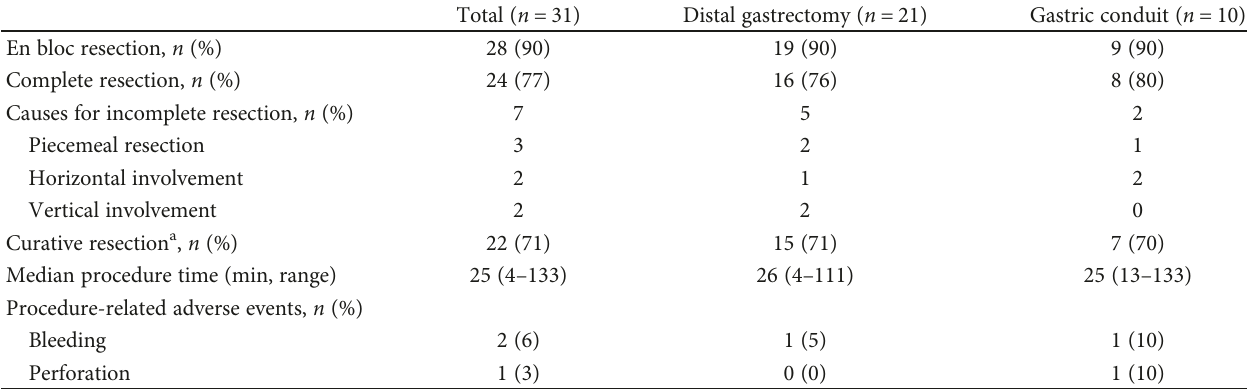
Table 2: Therapeutic outcomes of endoscopic submucosal dissection for gastric epithelial neoplasms in the remnant